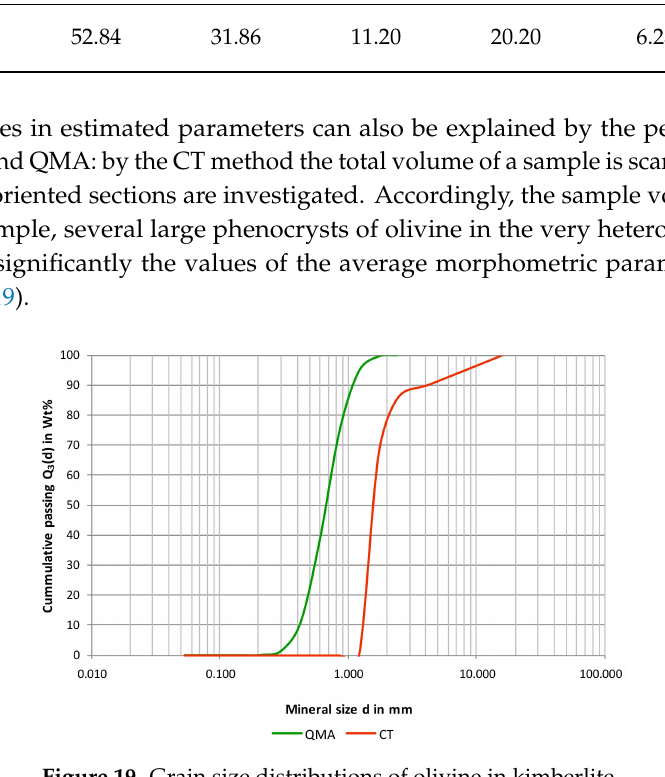
Figure 19. Grain size distributions of olivine in